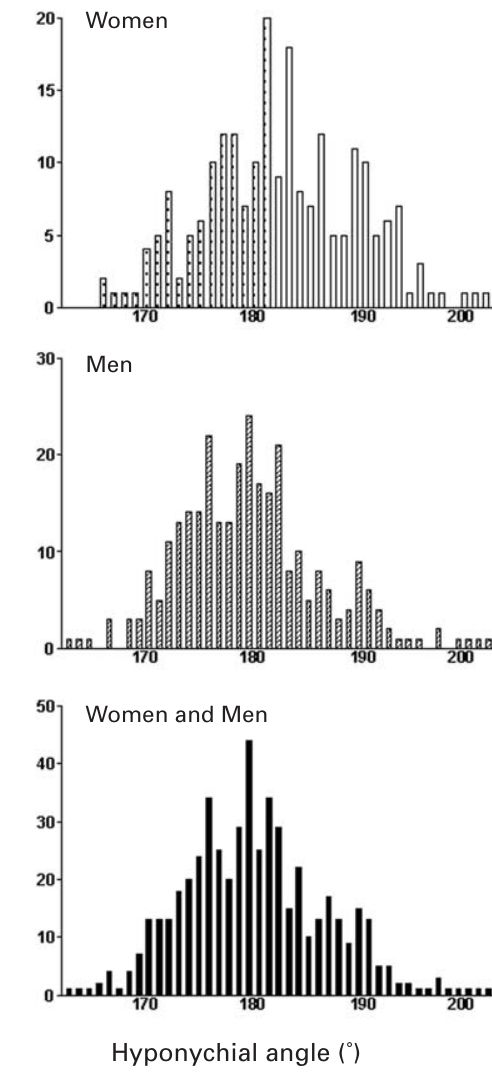
Distribution of hyponychial angles in healthy subjects. The distribution of hyponychial angles assessed by digital pho- tography and computerised analysis is shown for healthy women (upper panel), healthy men (middle panel) and for both sexes (lower panel) respectively.